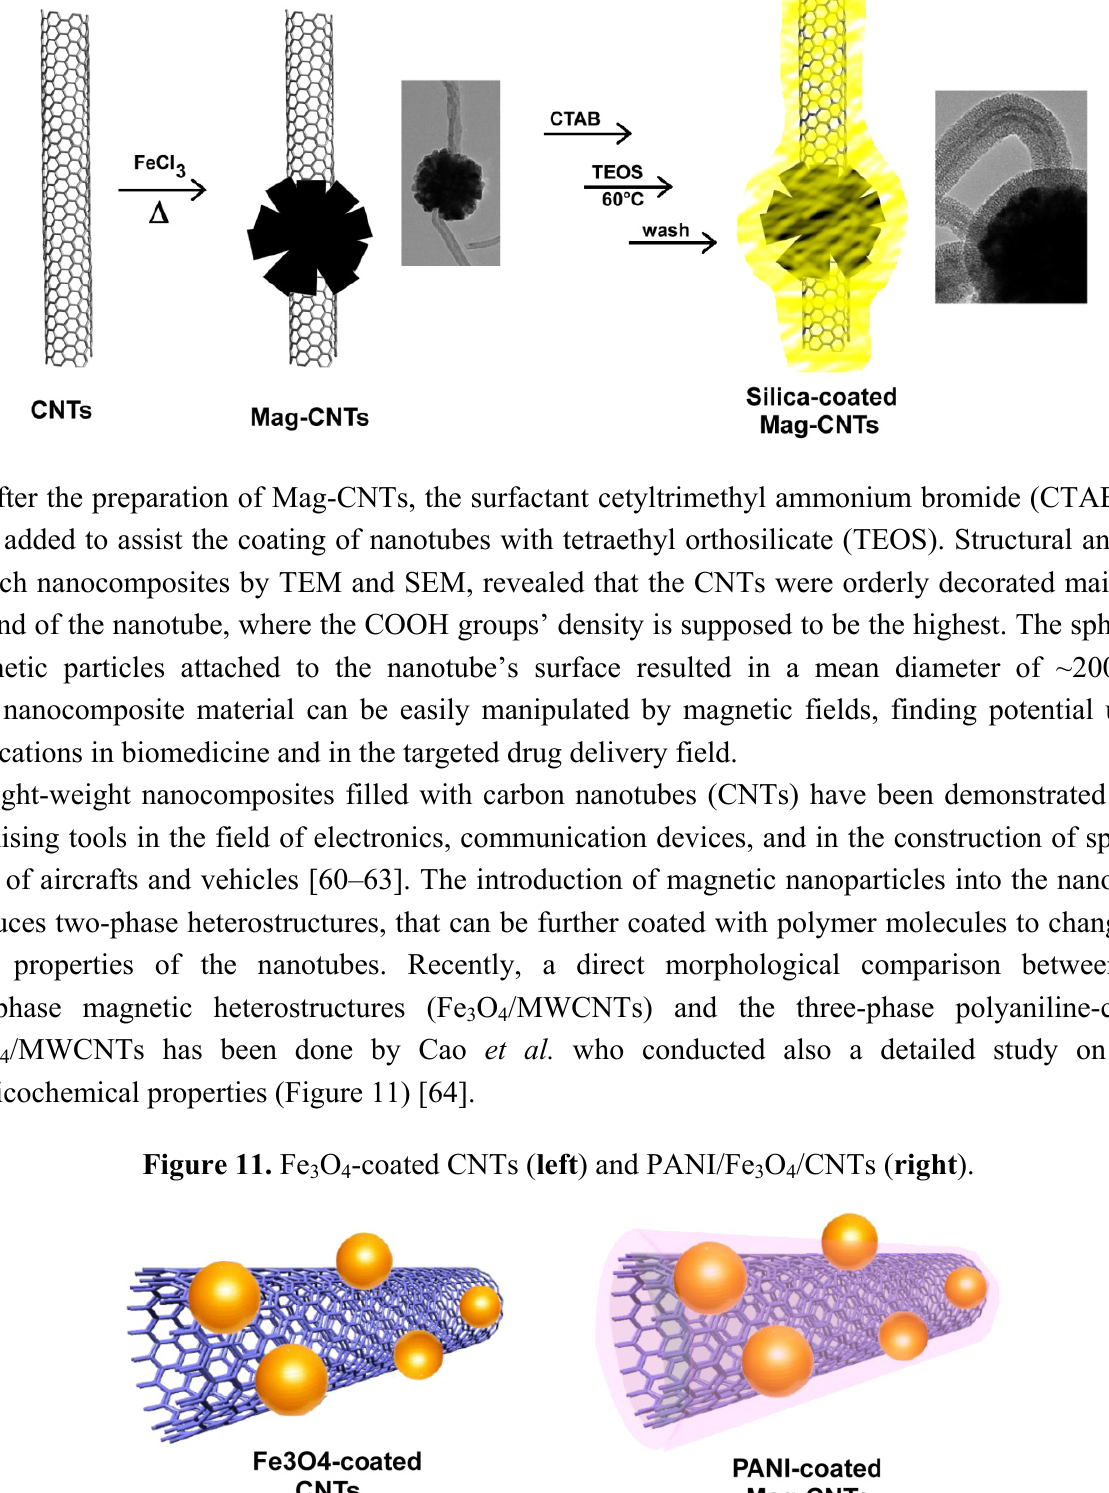
Figure 10. The synthetic route to Mag-CNTs@mSiO